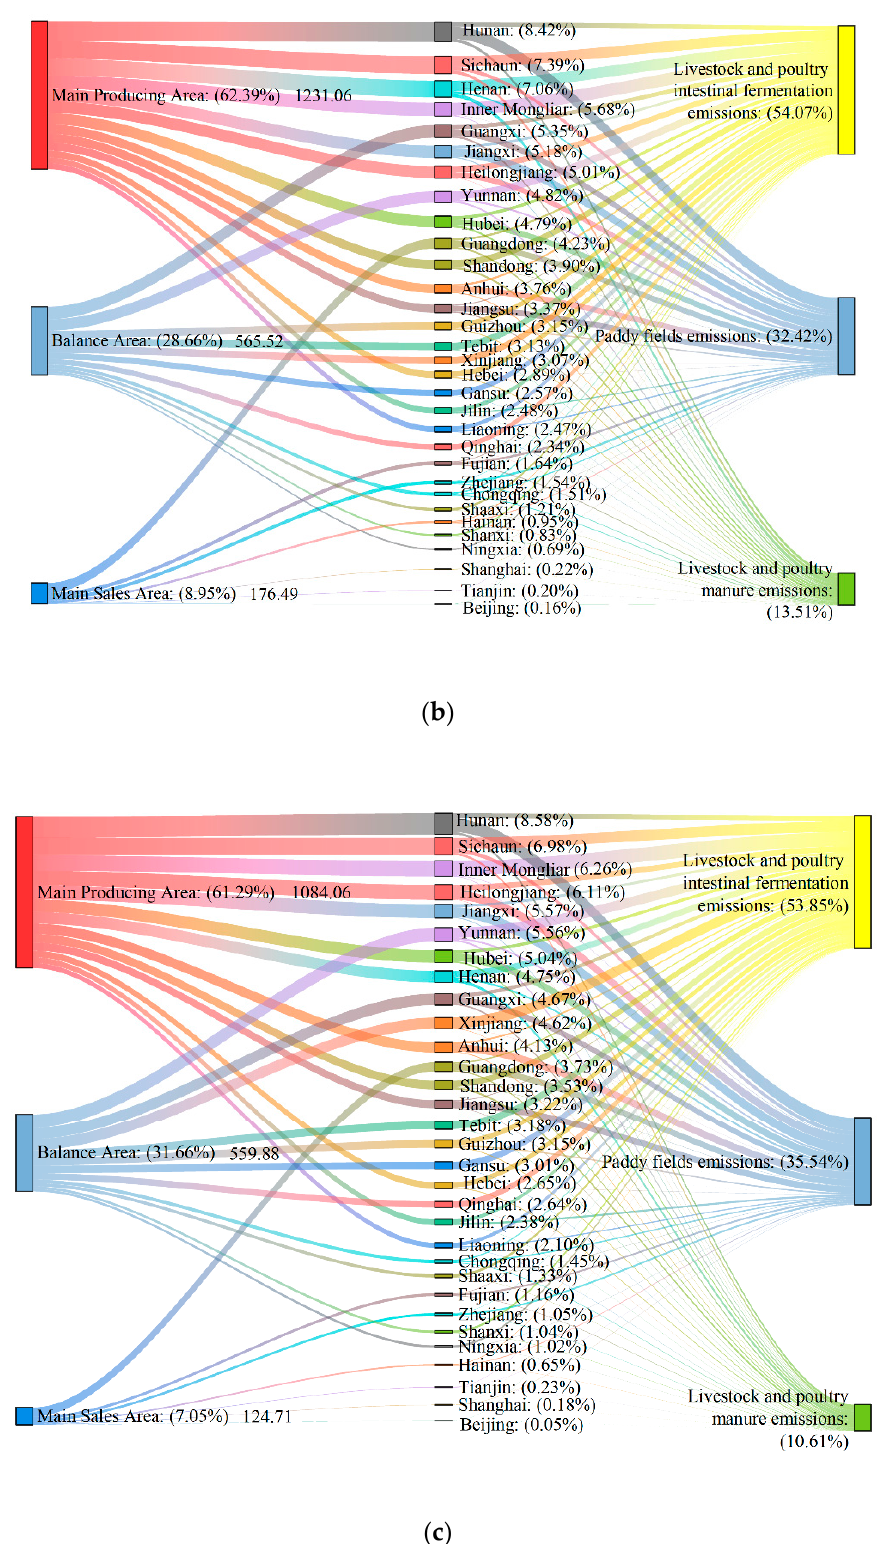
Figure 4. Agricultural methane emissions by provinces in China, 2000–2019. ( a ) 2000; ( b ) 2010; and ( c ) 2019.